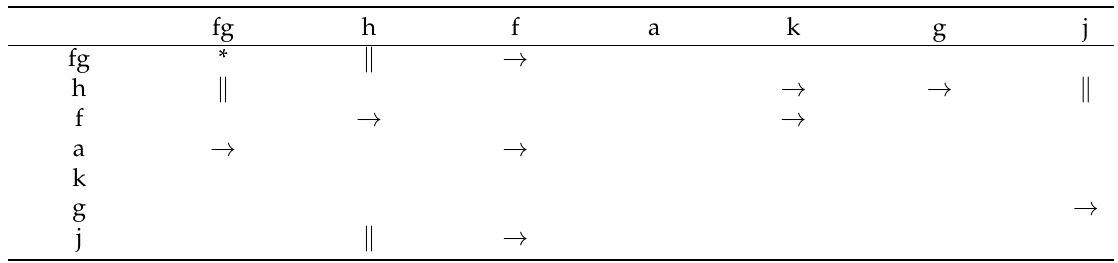
Table 1. Pattern Relation Table T of D